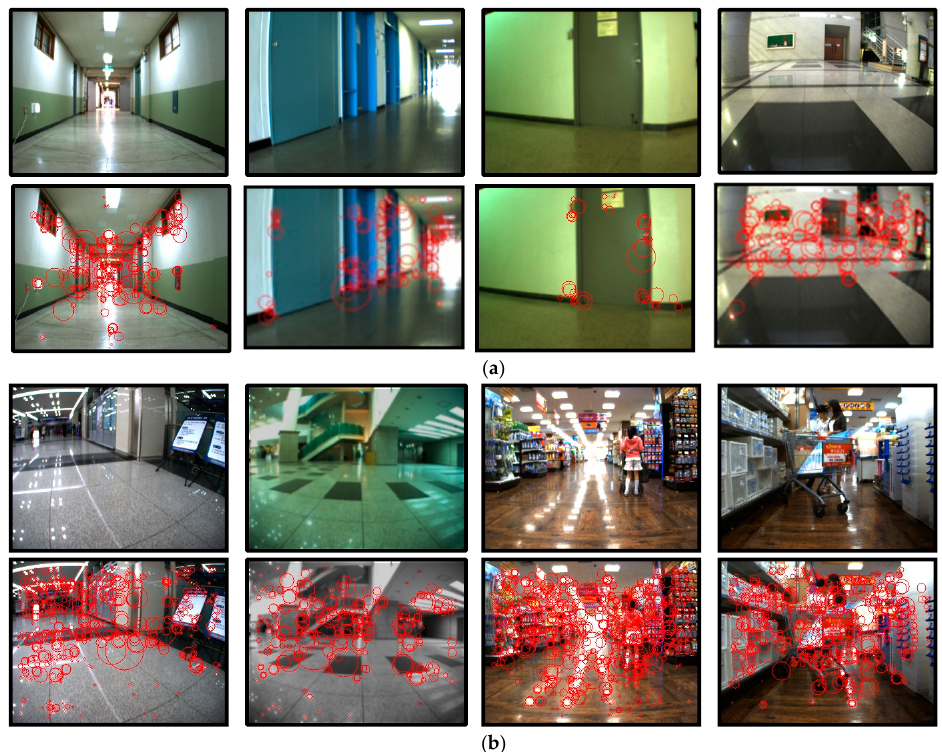
Figure 11. Situation awareness results: ( a ) Correctly recognized images; ( b ) Error images.